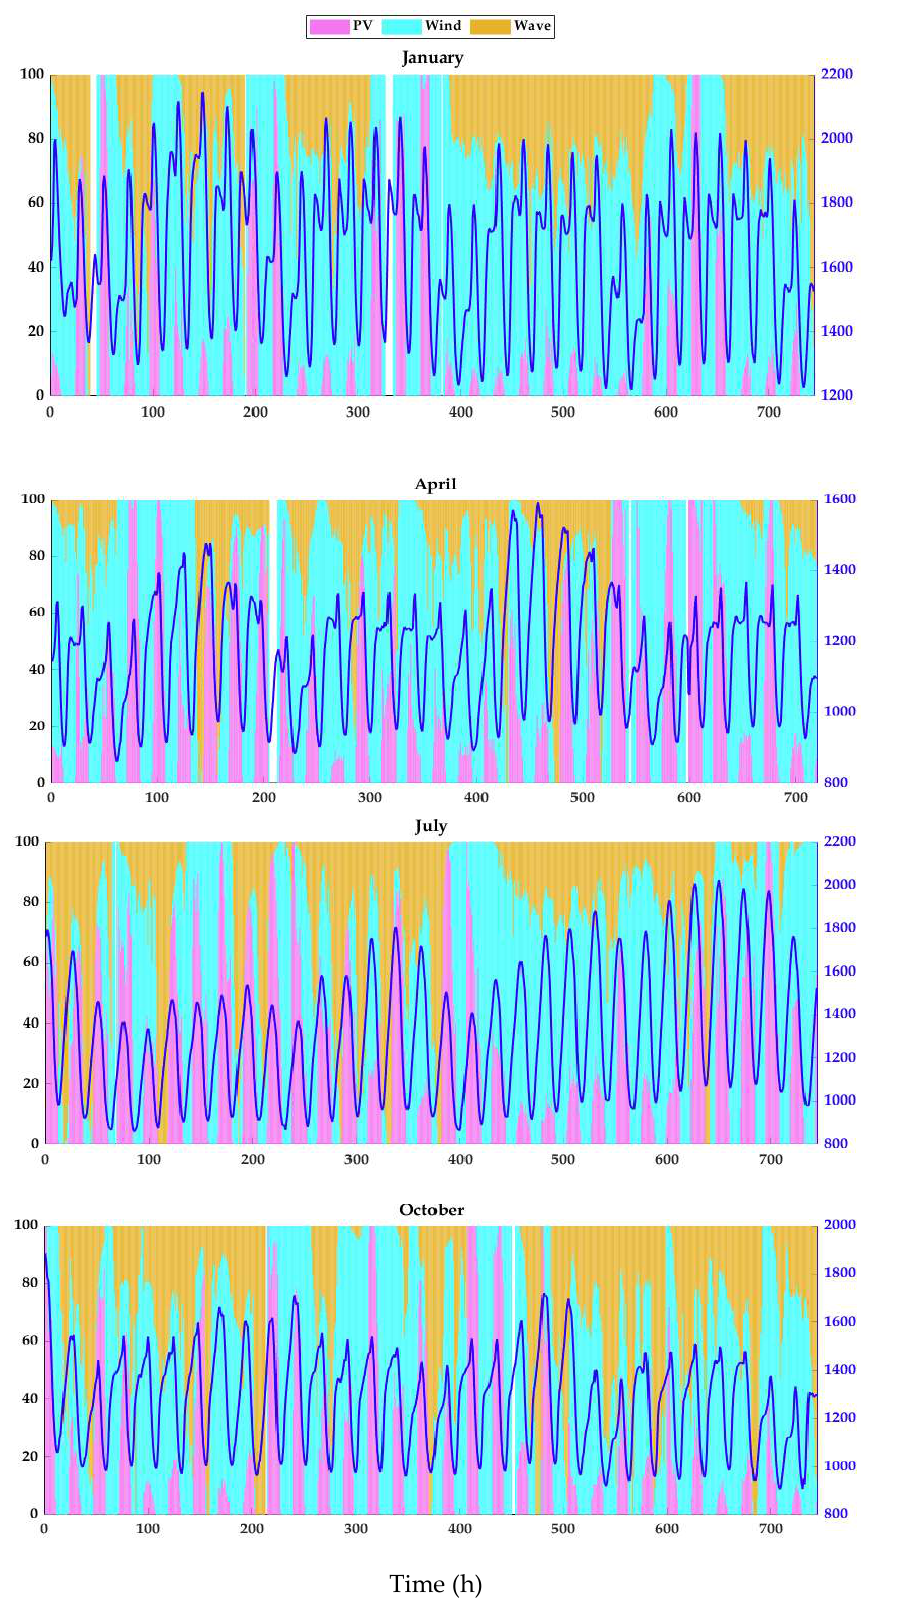
Figure 12. Individual contribution vs. demand—seasonal comparison after optimization . Table 4. Combined capacity factor before and after seasonal optimization.